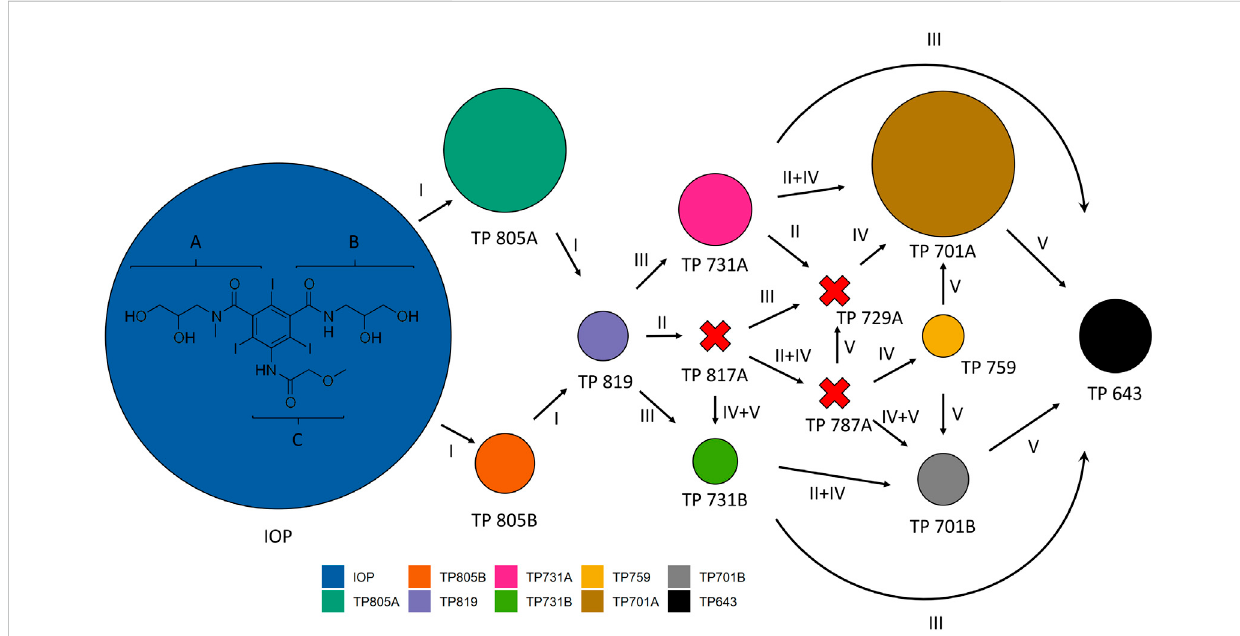
FIGURE 7 Pathwaysand mechanismsofiopromide (IOP) transformation adapted afterSchulzetal. (2008).Areasrepresent maximum concentrationsfound in Experiment 2 (mussels with periphyton) for each transformation product (TP) individually. Arrows: transformation pathways, Red-X: TP not found, (I) oxidationofprimaryhydroxygroups,II:oxidationofsecondaryhydroxygroups,III:removalofr-hydroxypropionicacidsidechains:directcleavageofthe amide-methylene bonds at side chains A and B, IV: oxidative decarboxylation of the r-ketopropionic side chain, V: deacetylation: cleavage of the amide-methylenebondsatsidechainsAandBoftransformationproductscontainingN-acetatemoieties.Formulasofdifferenttransformationproducts can be found in Schulz et al.